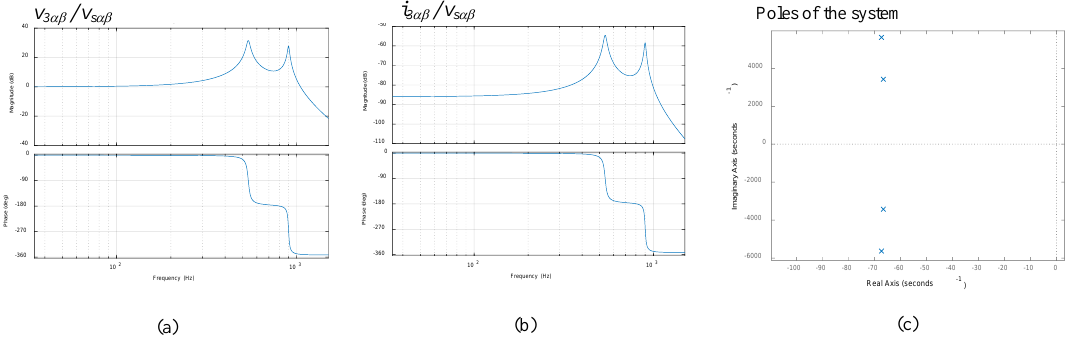
Figure 4. Bode diagrams and poles of an equivalent AC grid model, without connecting the ACISEF. ( a ) Bode of v 3 αβ ( s )/ v sαβ ( s ); ( b ) Bode of i 3 αβ ( s )/ v sαβ ( s ); ( c ) Poles of the system.